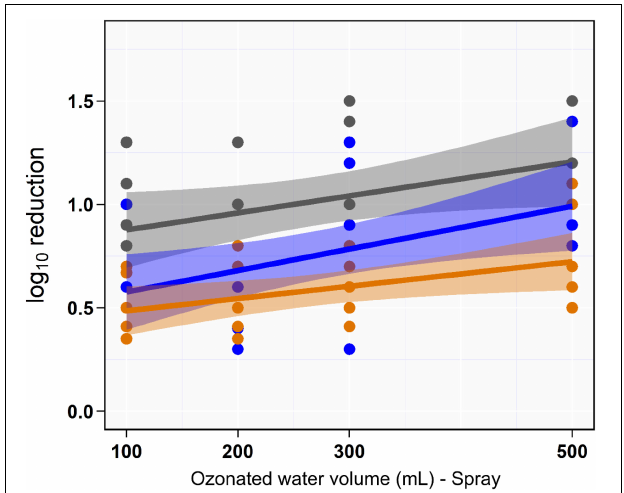
FIGURE 3 | Scatterplot of the linear relationship between volume of aqueous ozone and rate of Salmonella typhimurium – choleraesuis reduction in spraying water (gray), skin surface (blue), and subcutaneous